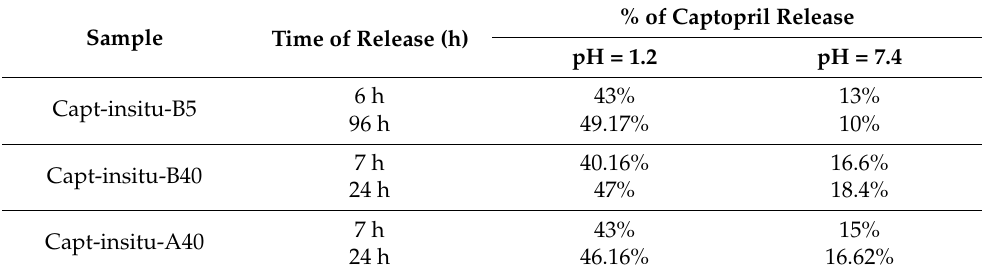
Table 3. The % of drug release in different buffer